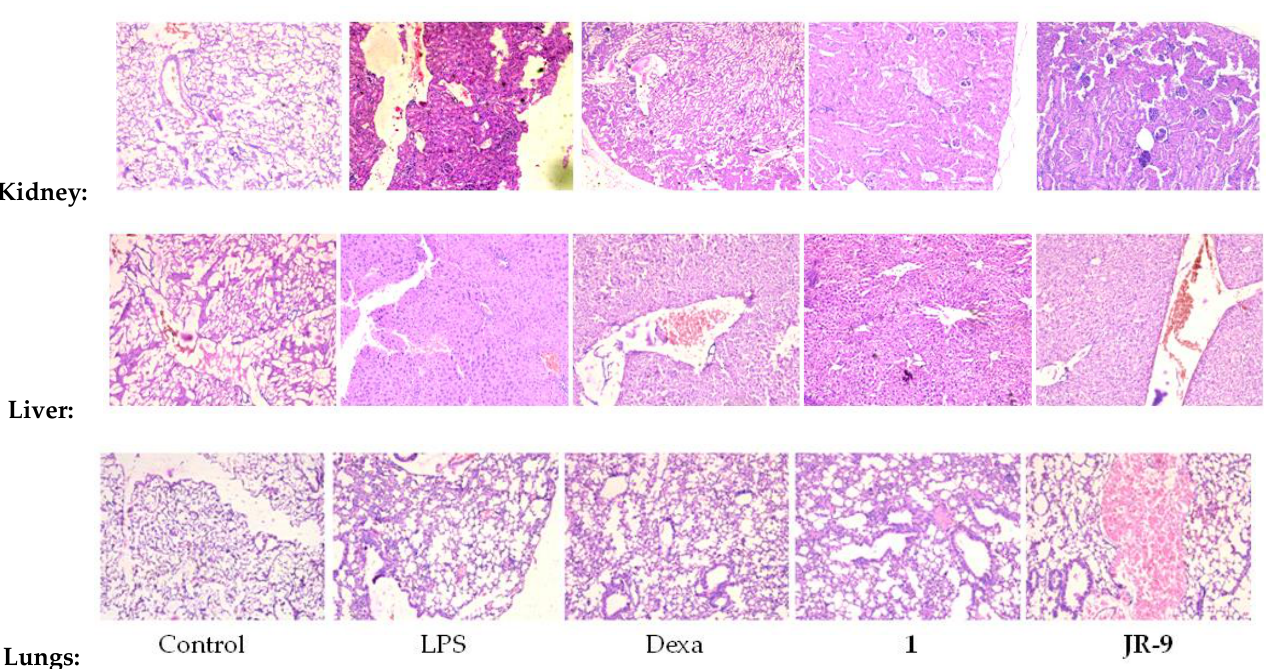
Figure 9. Histopathological analysis of kidney, liver, and lung tissues. BALB/c mice were injected with 1 and JR-9 (40 mg/kg) 1 h before LPS injection (1 mg/kg i.p), and kidney, liver, and lung tissues were harvested 24 h after LPS injection. JR-9 (40 mg/kg) protects the liver, kidney, and lungs from more than 1 (40 mg/kg) damage. These results depict H&E staining of a liver tissue section from the indicated group (40× magnification).